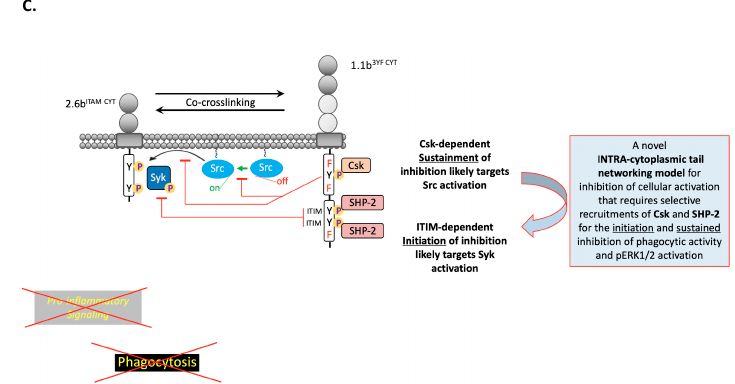
Figure 9. Hypothesized mechanism for the 1.1b WT CYT -mediated cross-inhibition of ITAM-driven phagocytosis and cellular activation. Co-crosslinking of 2.6b ITAM CYT with 1.1b 6YF CYT ( A ) when compared to co-crosslinking of 2.6b ITAM CYT with 1.1b WT CYT ( B ) provides the basis for the proposal of a novel intra-cytoplasmic tail networking model ( C ) that requires selective recruitment of Csk and SHP-2 by IpLITR 1.1b for initiation and sustainment of cross-inhibition as detailed in the discussion.